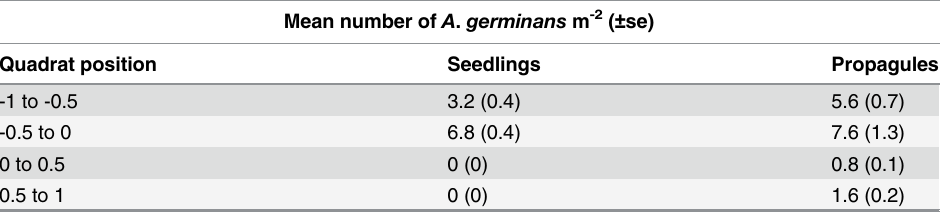
Mean number of A . germinans m -2 ( ± se). To assess mangrove abundance, transects initiating 1 m seaward and terminating 1 m landward of the 0 m position were completed for each experimental plot. At each position along transects, mangrove density was assessed within a 0.25 m 2